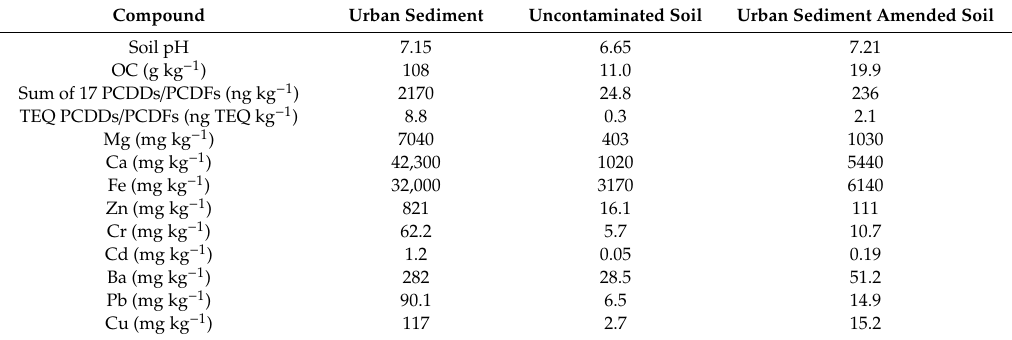
Table 1. The physico-chemical characteristics of the collected urban sediment, the uncontaminated soil used in the experiment and the soil mixed in a proportion of 1:10 with the urban